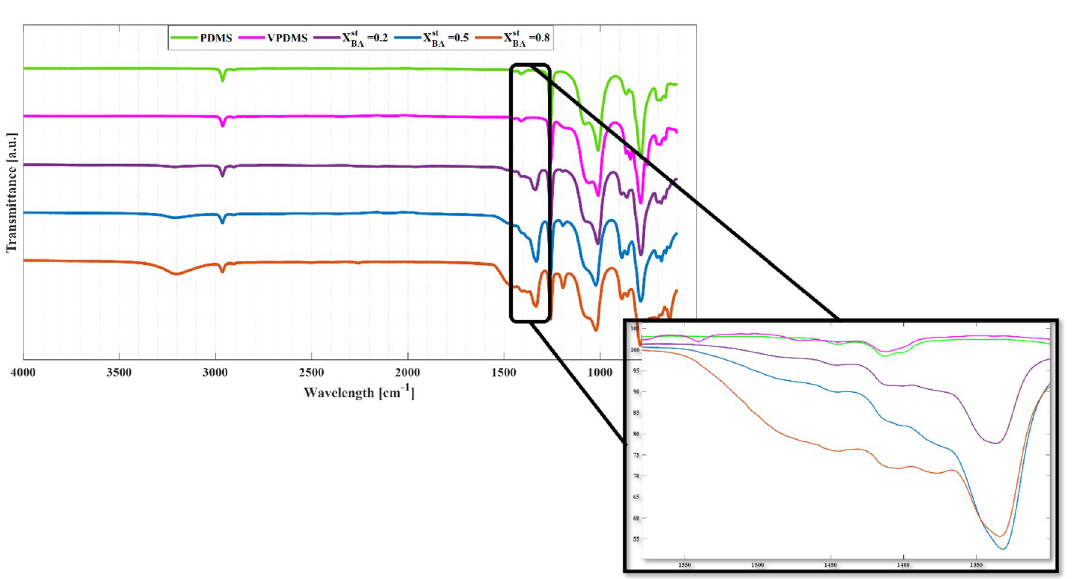
Figure 4. FT-IR spectra of PDMS precursor (green line), vinyl terminated PDMS (purple line) and samples synthesised with various stoichiometric ratios of boron to silicone. Insert in figure focusing around area of interest at approximately 1300 cm −1